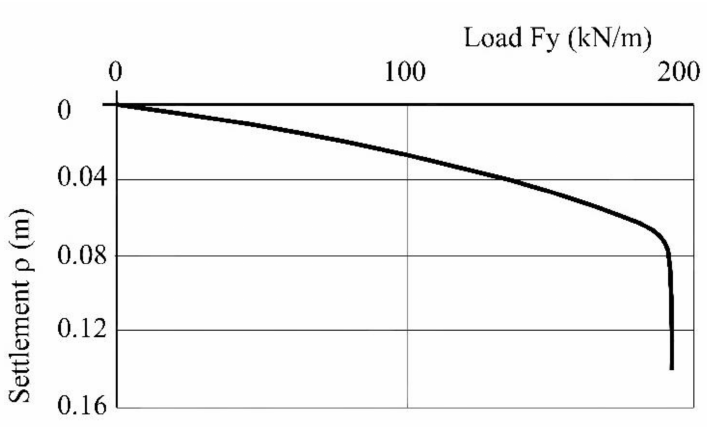
Figure 4. The load-settlement curve for foundation soil made of sand with ϕ (cid:48) = 35 ◦ , ψ (cid:48) = ϕ (cid:48) , and B = 1 m.